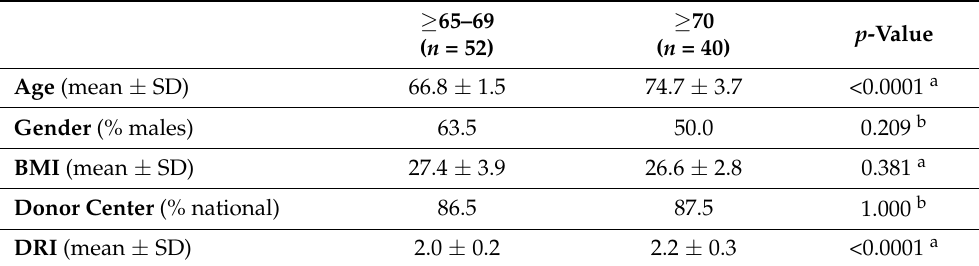
Table 3. Donor characteristics.